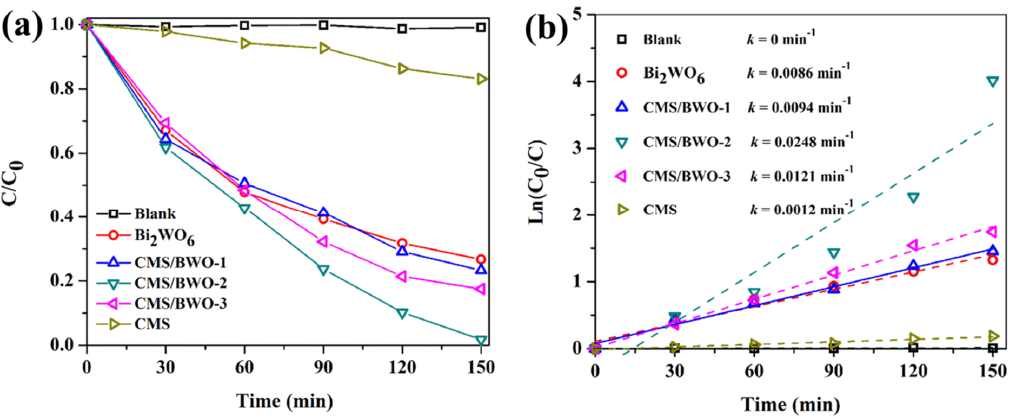
Figure 5. ( a ) Rhodamine B (RhB) (20.0 mg/L, 100.0 mL) removal curves and ( b ) the corresponding rate constant (k) of RhB degradation by the as-fabricated samples under visible